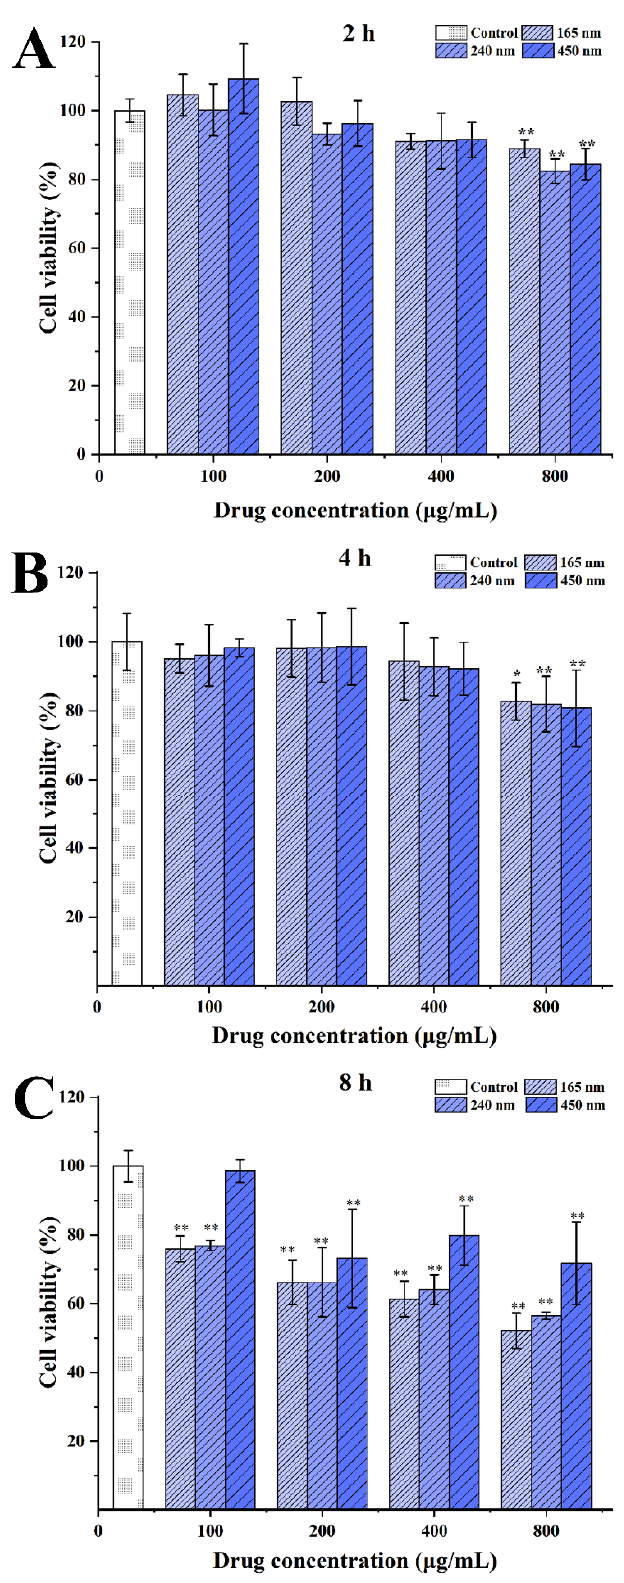
Figure 4. Concentration-dependent cytotoxicity of different sized CsA-NCs in Caco-2 cells at 2 h ( A ), 4 h ( B ) and 8 h ( C ) ( n = 6, means ± SD). * represents significantly different compared with control ( p < 0.05); ** represents extremely significantly different with control ( p < 0.01).